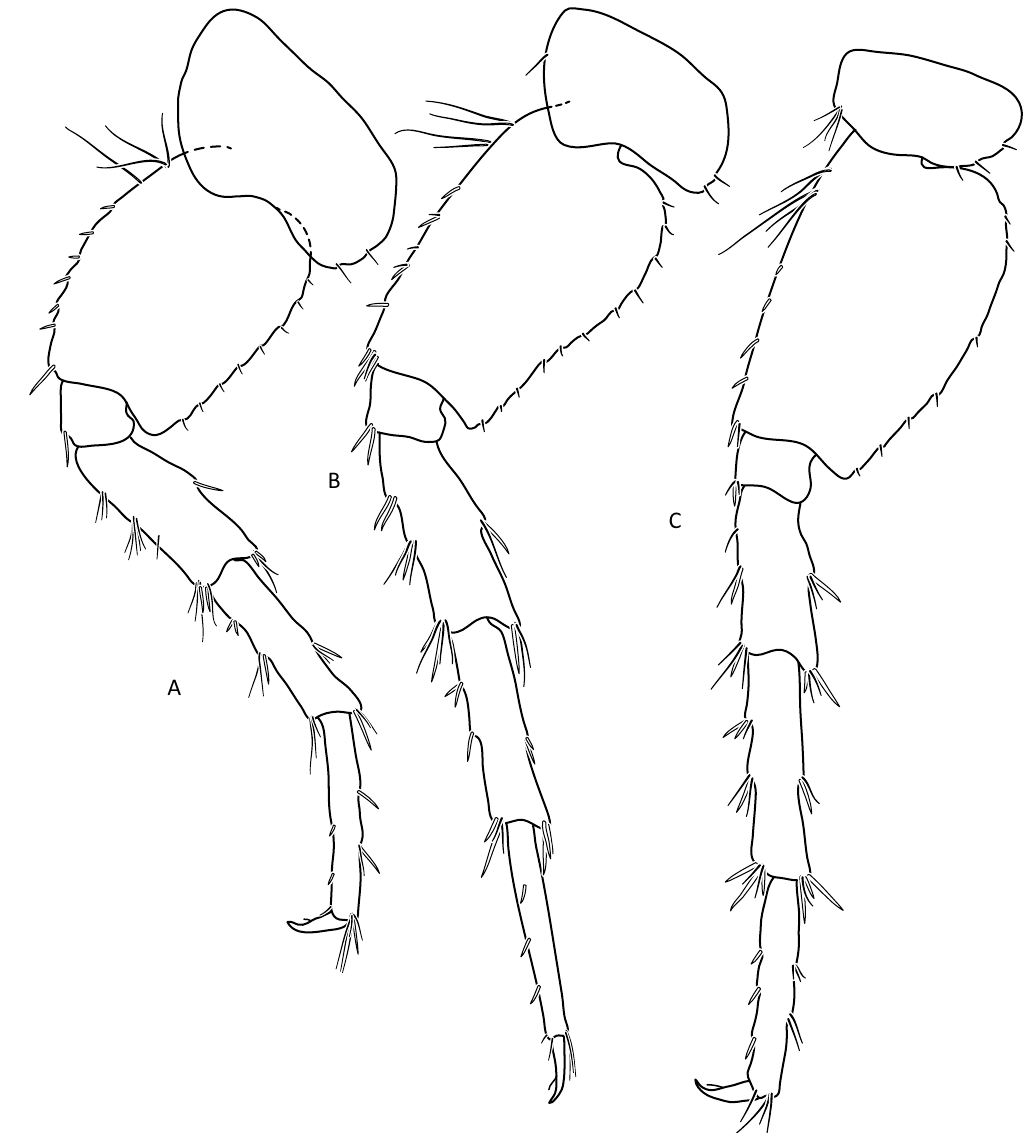
Figure 15. Gammarus tatrensis , female—12 mm. ( a ) pereopod 5, ( b ) pereopod 6, ( c ) pereopod